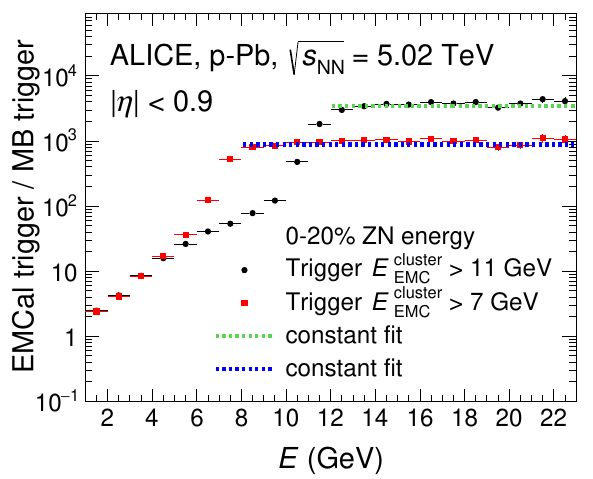
Figure 1 . Example of a trigger turn-on curve for the multiplicity class 0{20%. Each scaling factor was obtained by (cid:12)tting a constant to the plateau region (dashed lines) of the distribution. The resulting values are summarised in table 2.